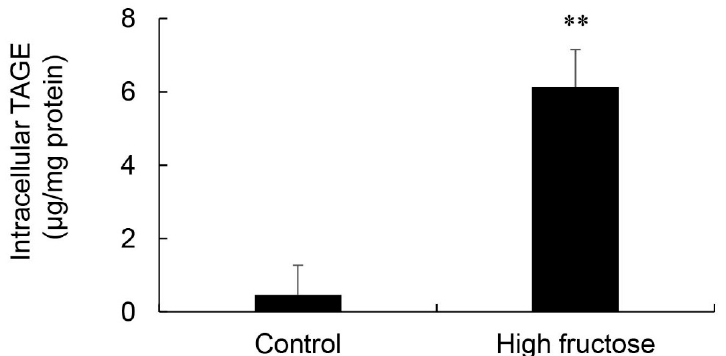
Figure 7. Calculation of intracellular TAGE levels in Sprague Dawley rat primary hepatocytes. Control; control medium ( n = 4), High fructose; high fructose medium ( n = 4). Cell lysates (4.0 µ g of protein / lane) were loaded on PVDF membranes, and proteins were probed with the anti-TAGE antibody or neutralized anti-TAGE antibody. The amount of TAGE was calculated based on a standard curve for TAGE-BSA. Data are shown as means ± S.D. ( n = 4). p -Values were based on the Mann-Whitney U-test. ** p < 0.01 vs.